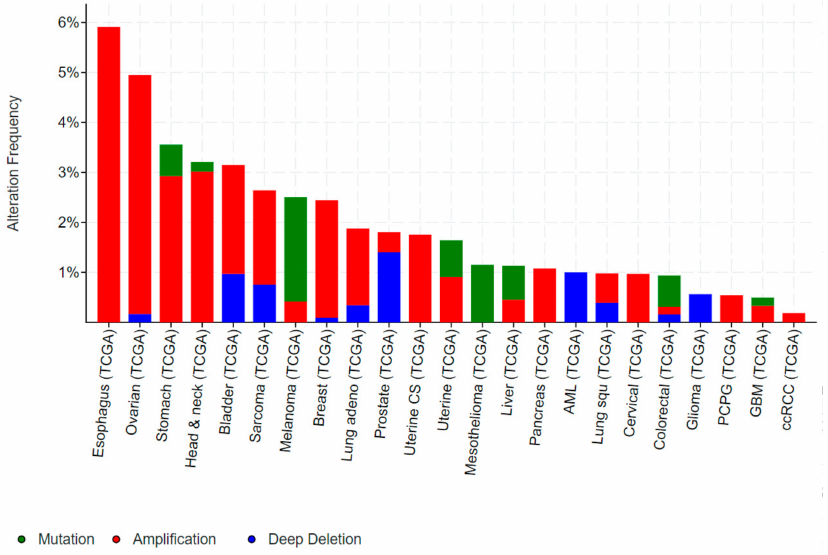
Figure 5. Genomic alterations in ELF5 in human cancers. Data from cancer bioportal. Only showing cancers in which >50 cases were